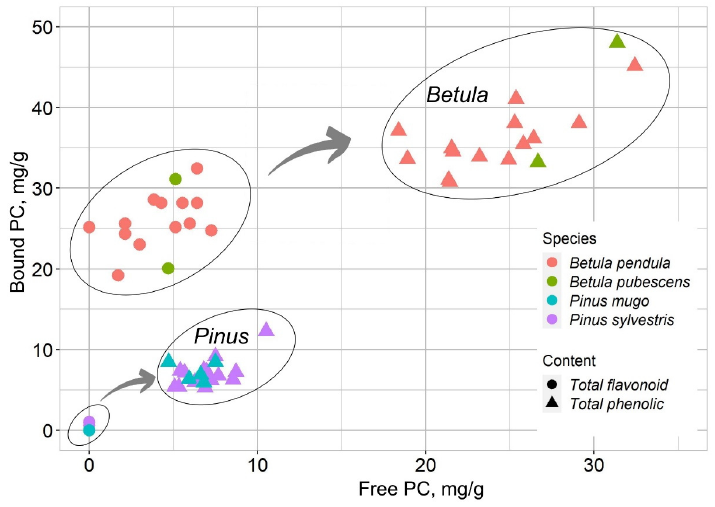
Figure 2. Total relative distribution of free PC, bound PC and flavonoids in Betula and Pinus pollen extracts.